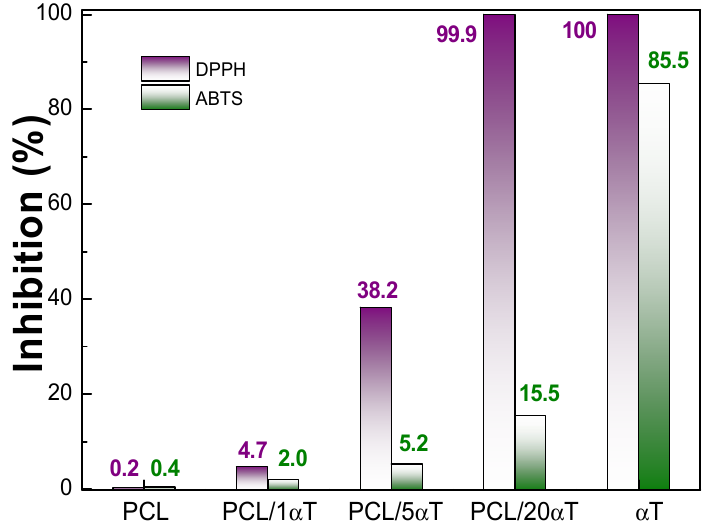
Figure 9. Radical scavenging activity of PCL/ α T electrospun fibers.